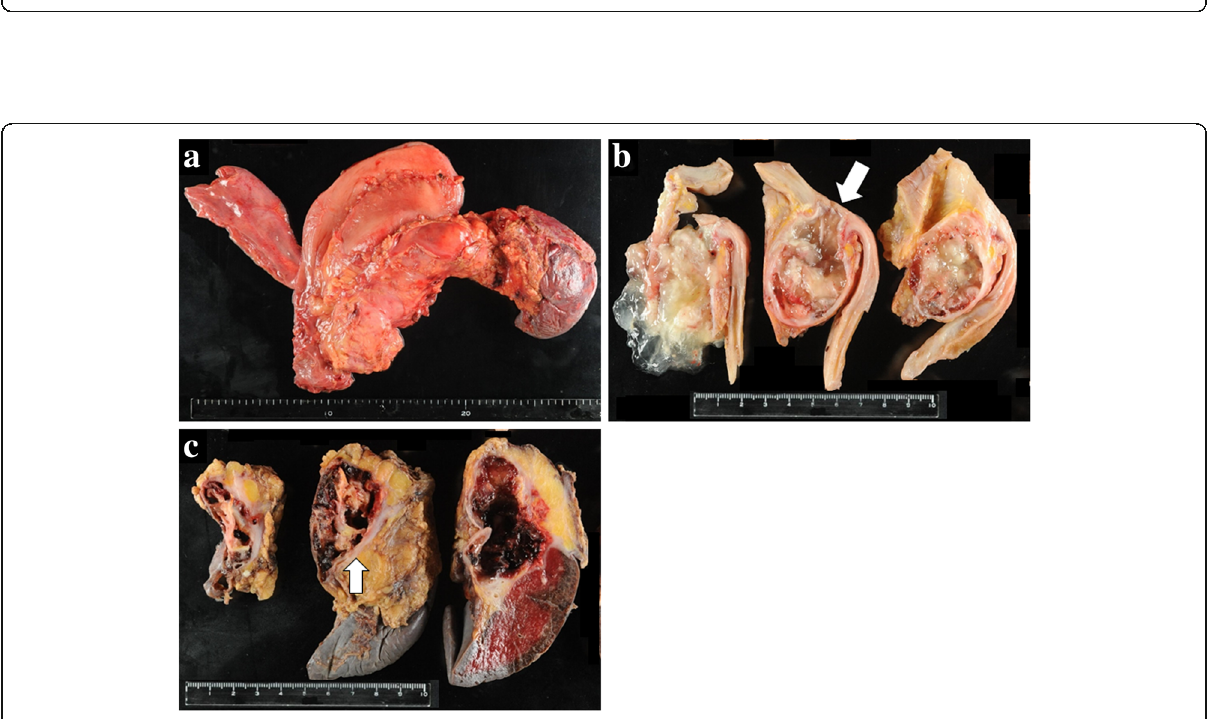
Fig. 3 Macroscopic findings for the resected specimen. a Most of the cut surface of the whole pancreas was occupied by the dilated main pancreatic duct and the mucus accompanied by atrophy of the pancreatic parenchyma. b A gastropancreatic fistula was identified between the main pancreatic duct and the posterior wall of the gastric body. c A splenopancreatic fistula was identified (white arrow), and bleeding and infarction were detected in the spleen with mucus